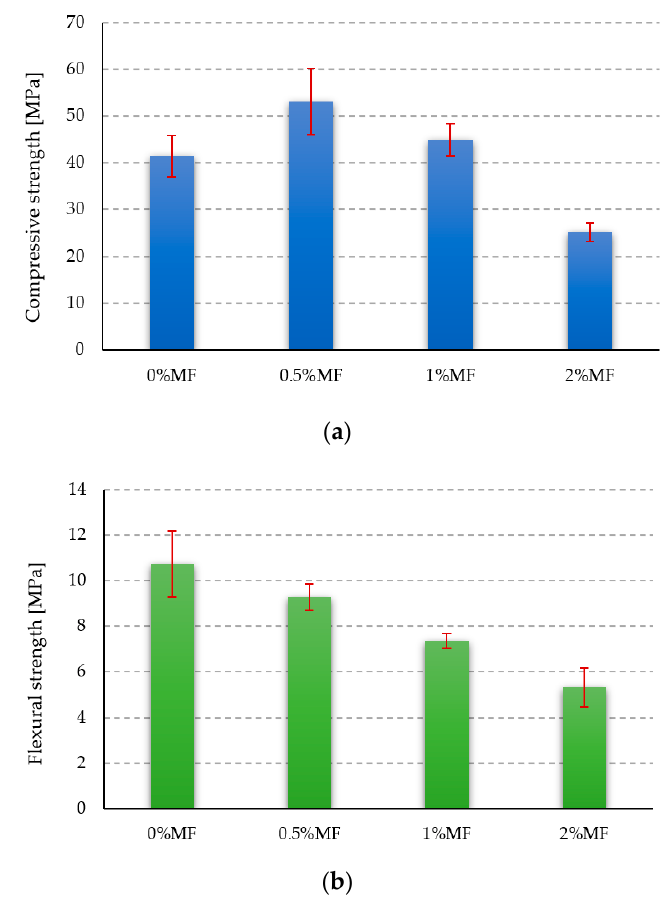
Figure 7. Compressive ( a ) and flexural ( b ) strength of tested materials. The compressive strength for the samples made of the reference material (with pure geopolymer matrix) reached a value of about 41 MPa. Better results were obtained for geopolymer composites with the addition of 0.5% and 1% by weight of melamine fibers, for which the compressive strength was approximately 53 MPa and 45 MPa,